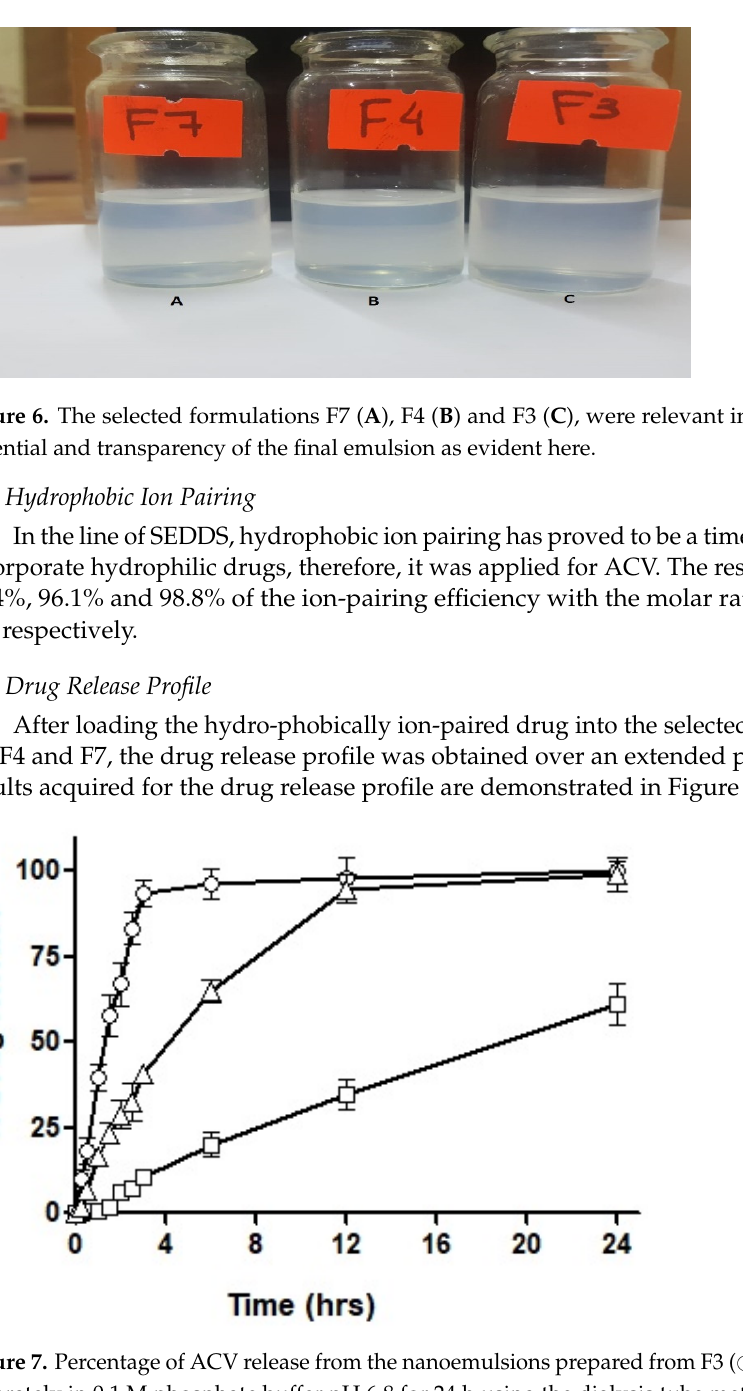
), F4 ( (cid:3) ) and F7 ( (cid:52) ) (cid:35)